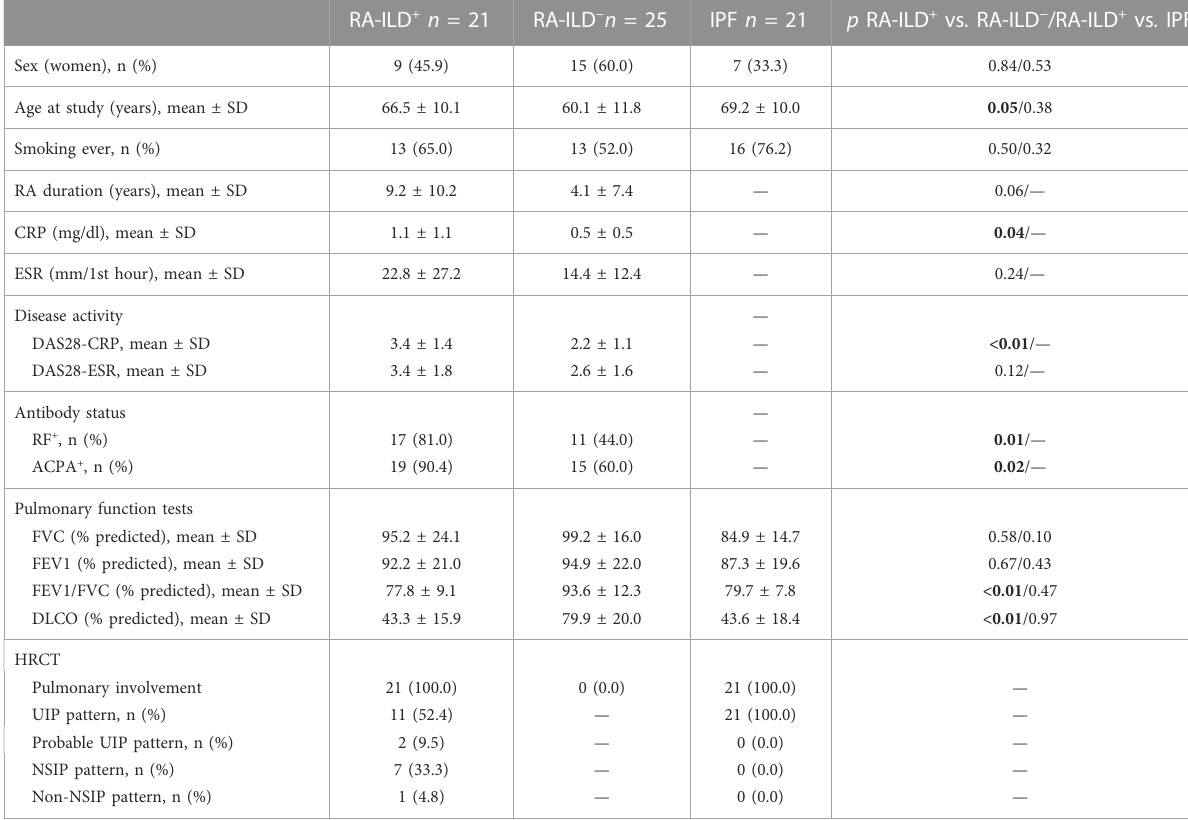
TABLE 1 Demographic and clinical characteristics of all the patients included in the